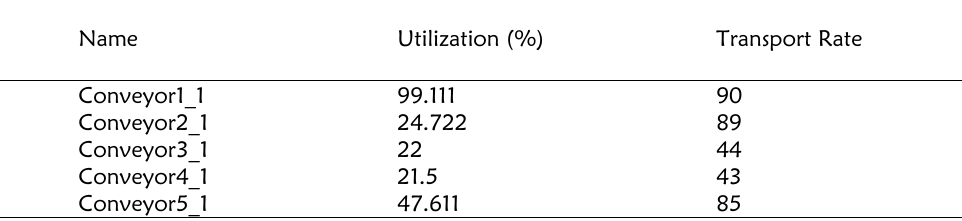
Table 4: Utilization of conveyer